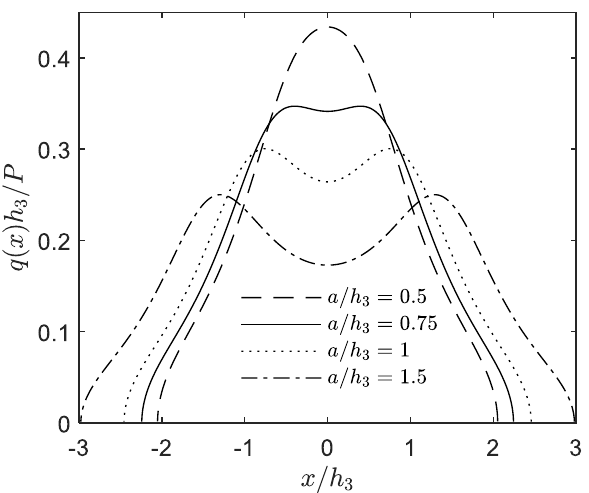
a h on the distribution of non – di- 3